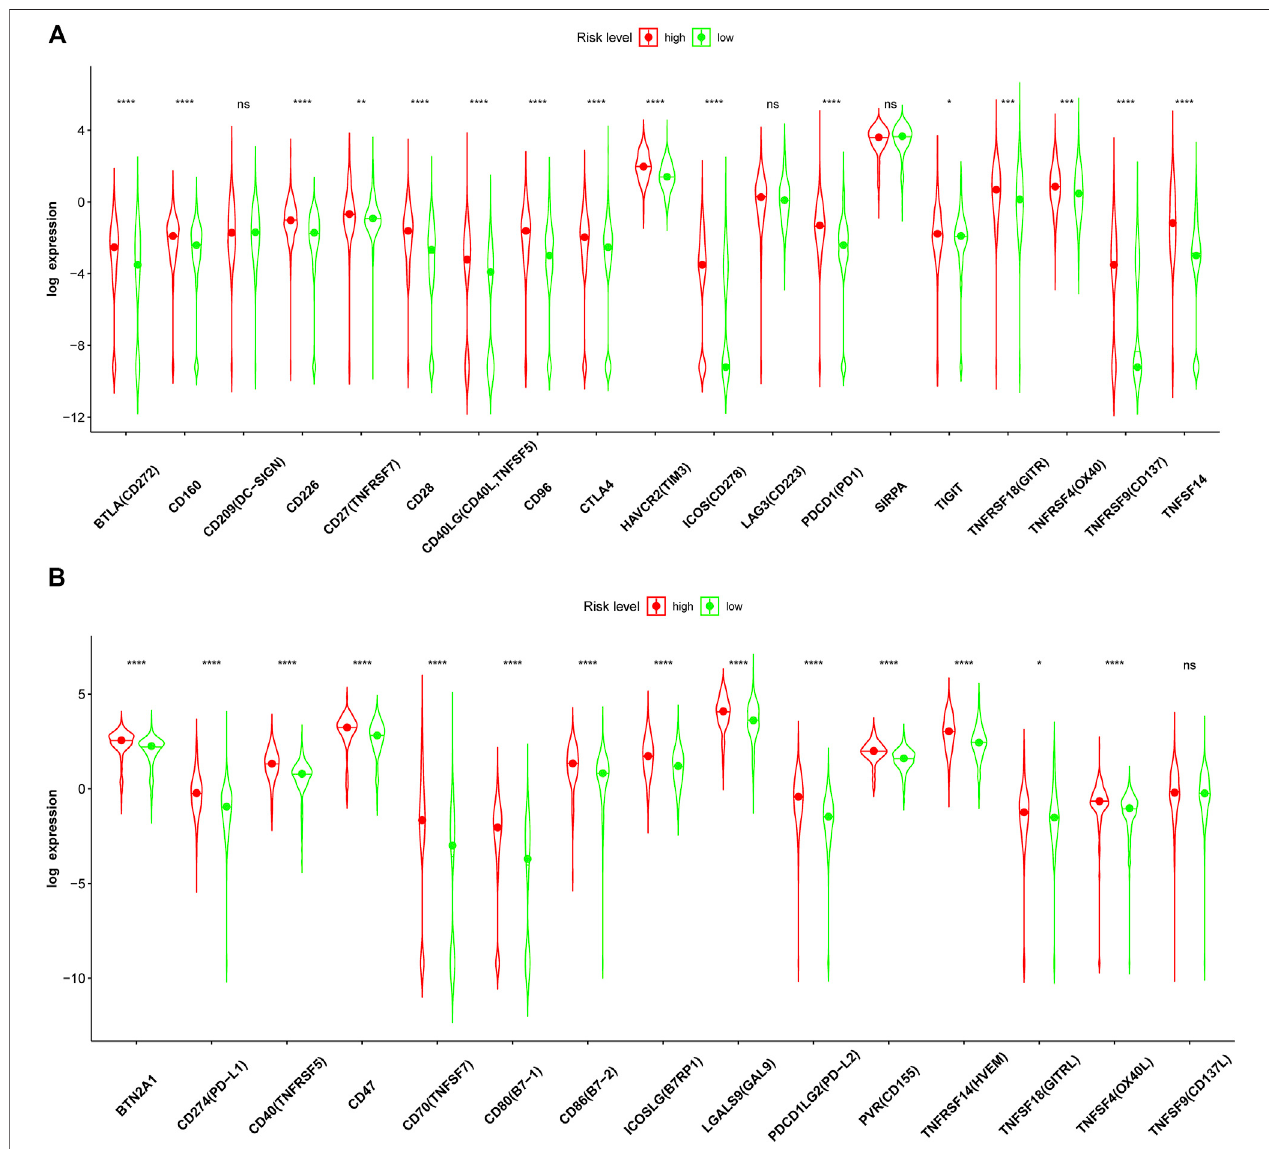
FIGURE12| ImmunecheckpointanalysisintheCGGA693cohort. (A,B) Expressionofimmunecheckpointsbetweenthehigh-and low-riskgroupsinthetraining CGGA693 cohort.